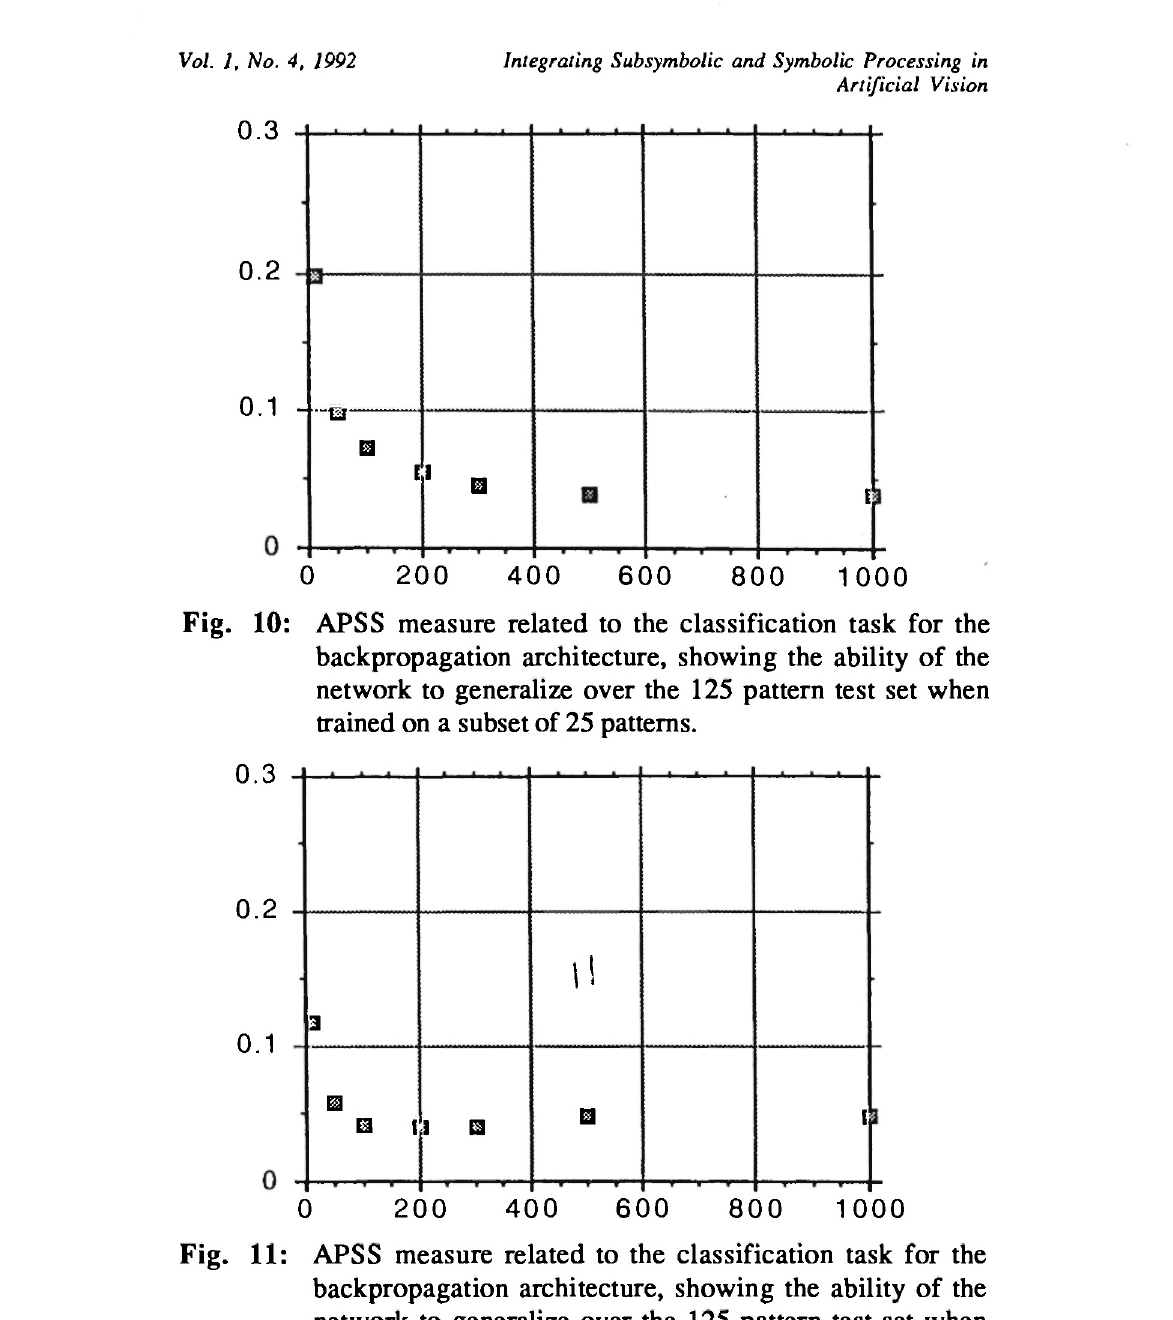
APSS measure related to the classification task for the backpropagation architecture, showing the ability of the network to generalize over the 125 pattern test set when trained on a subset of 75 patterns. It is worth noting that APSS reaches a minimum after 200 training epochs and an overlearning phenomenon when learning is carried